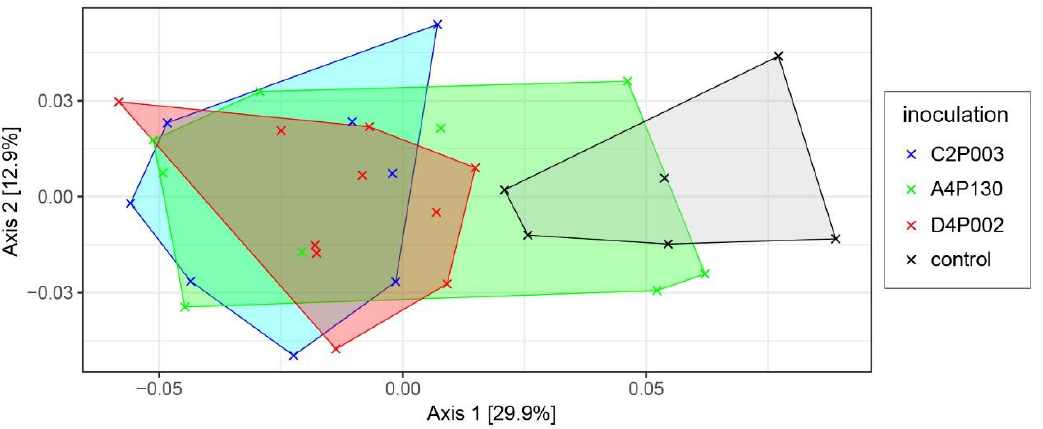
Figure 5. Composition of the bacterial microbiome of ash seedlings inoculated with A. altamirensis C2P003, B. velezensis A4P130 and L. fraxinea D4P002 as well as control plants. Two different taxonomic levels are demonstrated.